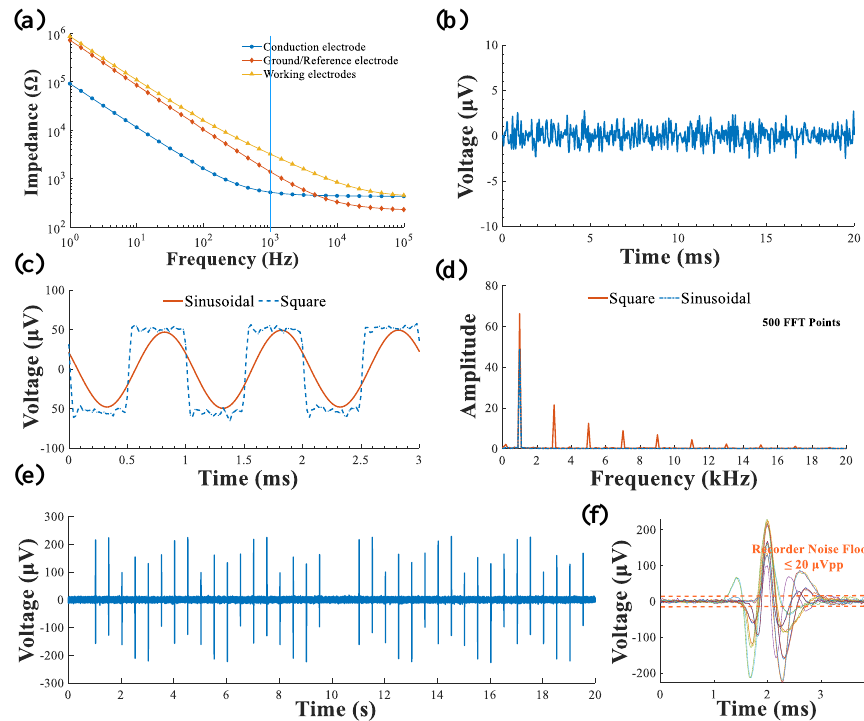
Figure 2. Developed system performance characterization. ( a ) In vitro impedance measurement of the electrodes with different sizes for the functional sites; ( b ) measured input-referred noise of the system; ( c ) measured output of the ± 50 µ V, 1 kHz square wave and the ± 50 µ V, 1 kHz sinusoidal wave; ( d ) measured output spectrum of the ± 50 µ V, 1 kHz square wave and the ± 50 µ V, 1 kHz sinusoidal wave; ( e ) measured output data segments of the designed iEEG signal acquisition system, where the recorder is fed with an emulated spike signal that is generated by a digital neural signal simulator; ( f ) the neural spikes signal and the recorder noise floor.